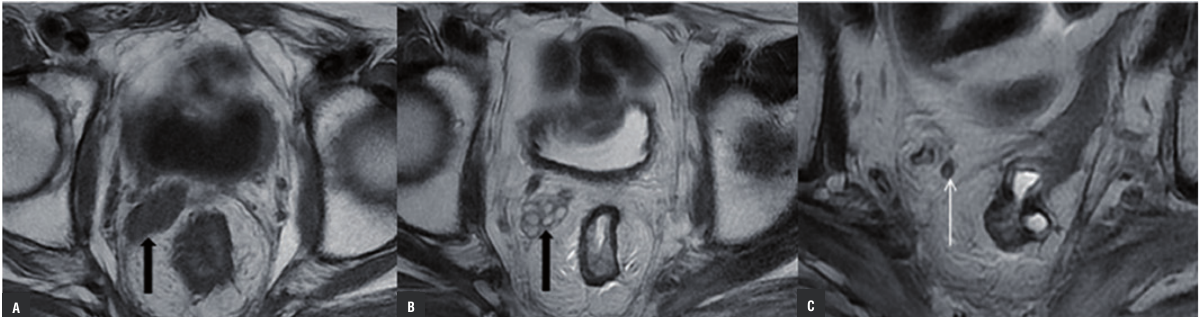
Figure 1 - Left sv agenesis of a 63 years old male patient who had colon ca. Axial (a) T1 weighted MR image, axial; (b) T2 weighted MR images show left sv absence. Right sv normal (thick black arrow). Axial (c) T2 weighted MR image show; sv absence was associated with left vD absence. Right vD normal (white thin arrow). Postoperative changes at the anastomosis line of the rectosigmoid junction.